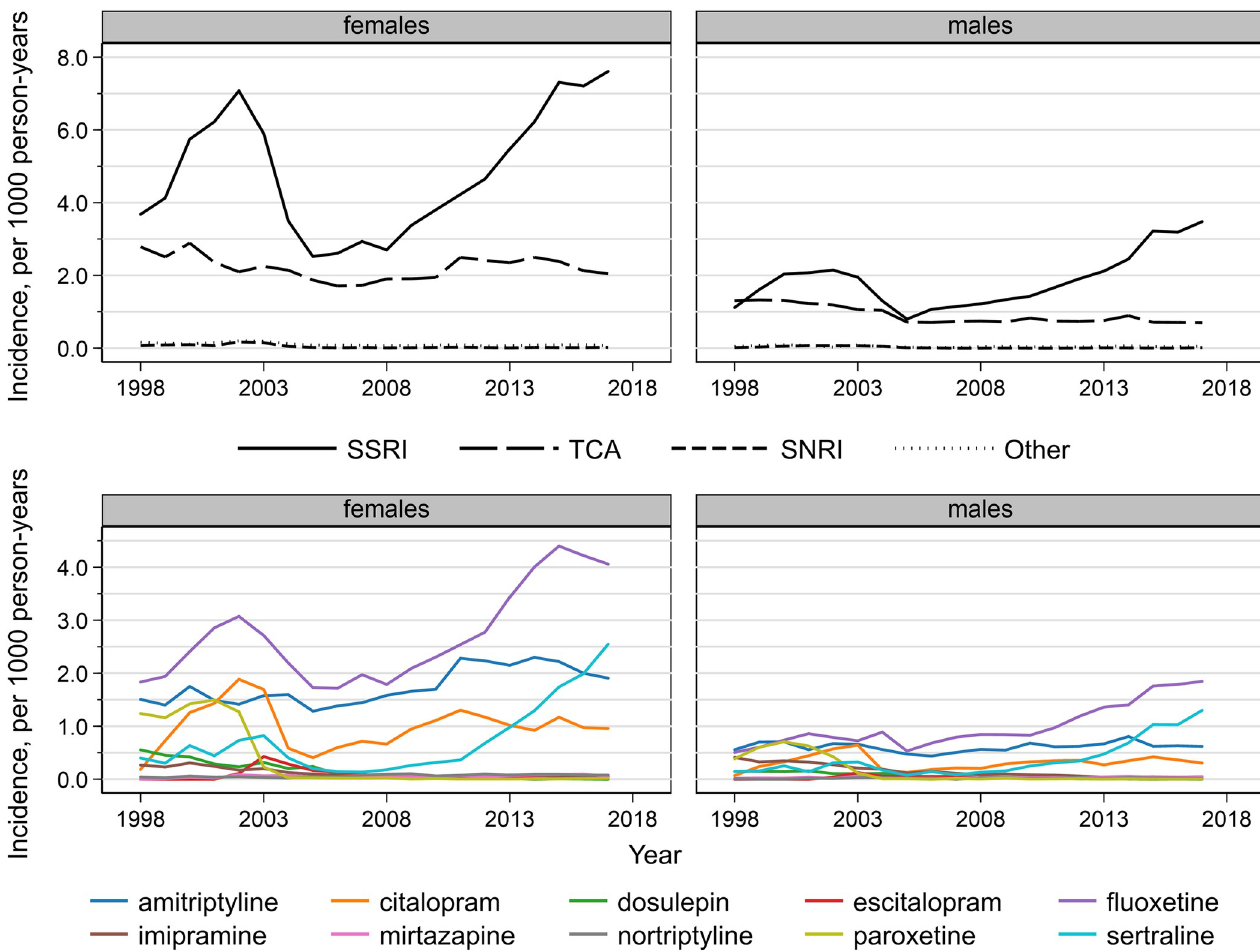
Fig 3. Antidepressant drug class and individual drug incidence rates per 1,000 person-years in 12- to 17-year-olds, England 1998–2017, by sex. SNRI, serotonin and norepinephrine reuptake inhibitor; SSRI, selective serotonin reuptake inhibitor; TCA, tricyclic and related antidepressant